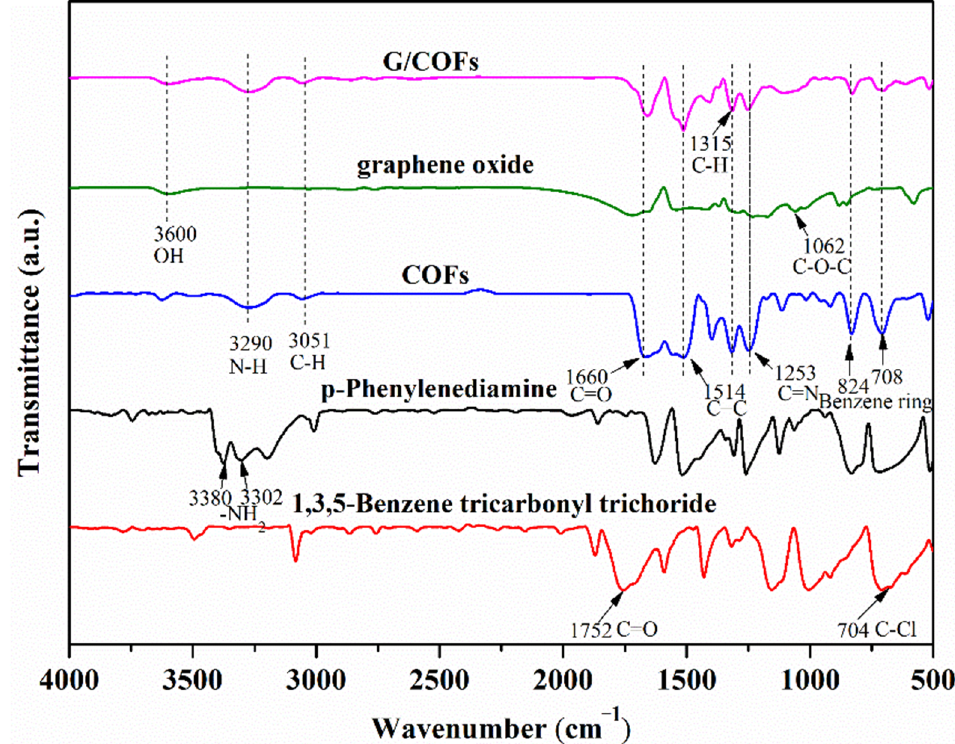
Figure 1. FT − IR spectra of p − Phenylenediamine, 1,3,5 − Benzenetricarbonyl trichloride, graphene ox ‐ Figure 1. FT-IR spectra of p-Phenylenediamine, 1,3,5-Benzenetricarbonyl trichloride, graphene oxide, ide, COFs, and G/COFs. COFs, and G/COFs.